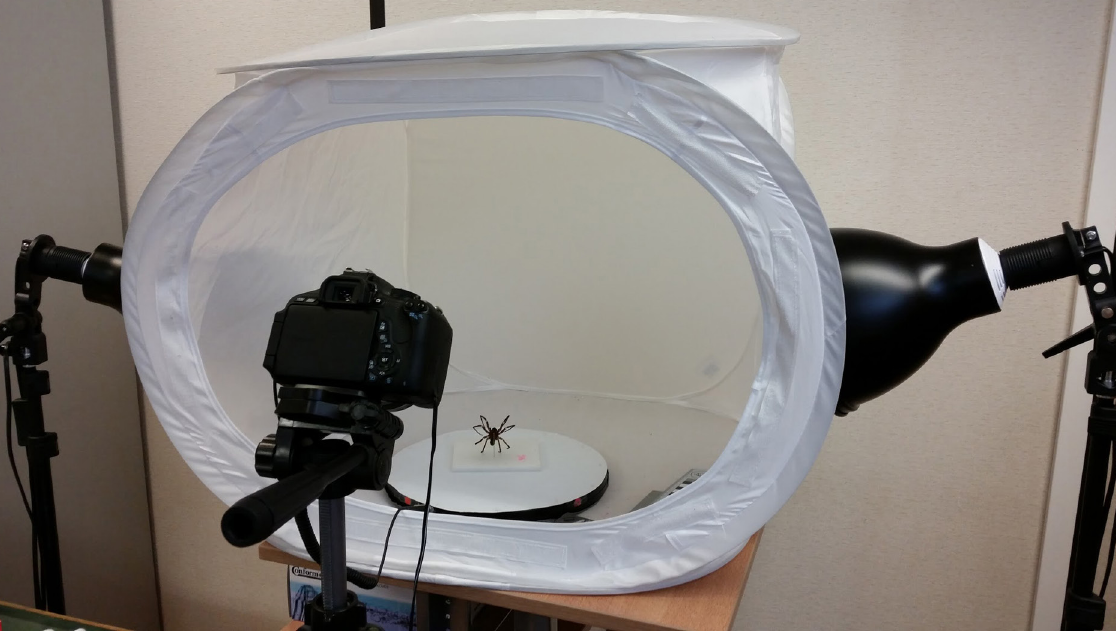
Fig. 3.1. Photogrammetry set-up with a specimen on a manual turntable, a Canon DSLR on a tripod, 2 studio lights and a light